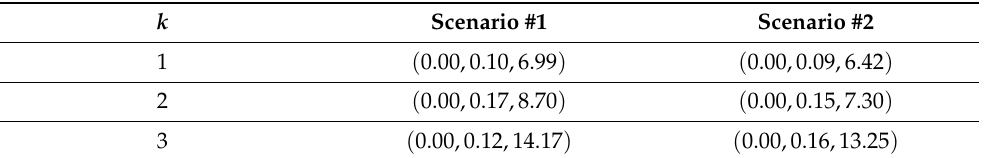
Table 3. Consistency evaluation results.